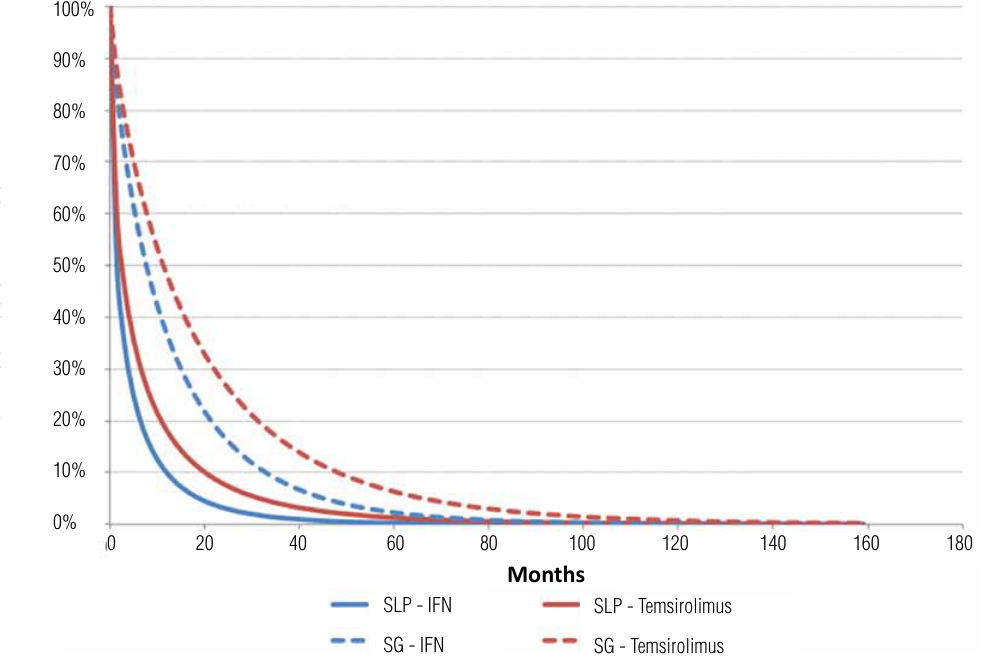
Figure 6 - Free survival progression and total survival curves for first line treatment of high risk